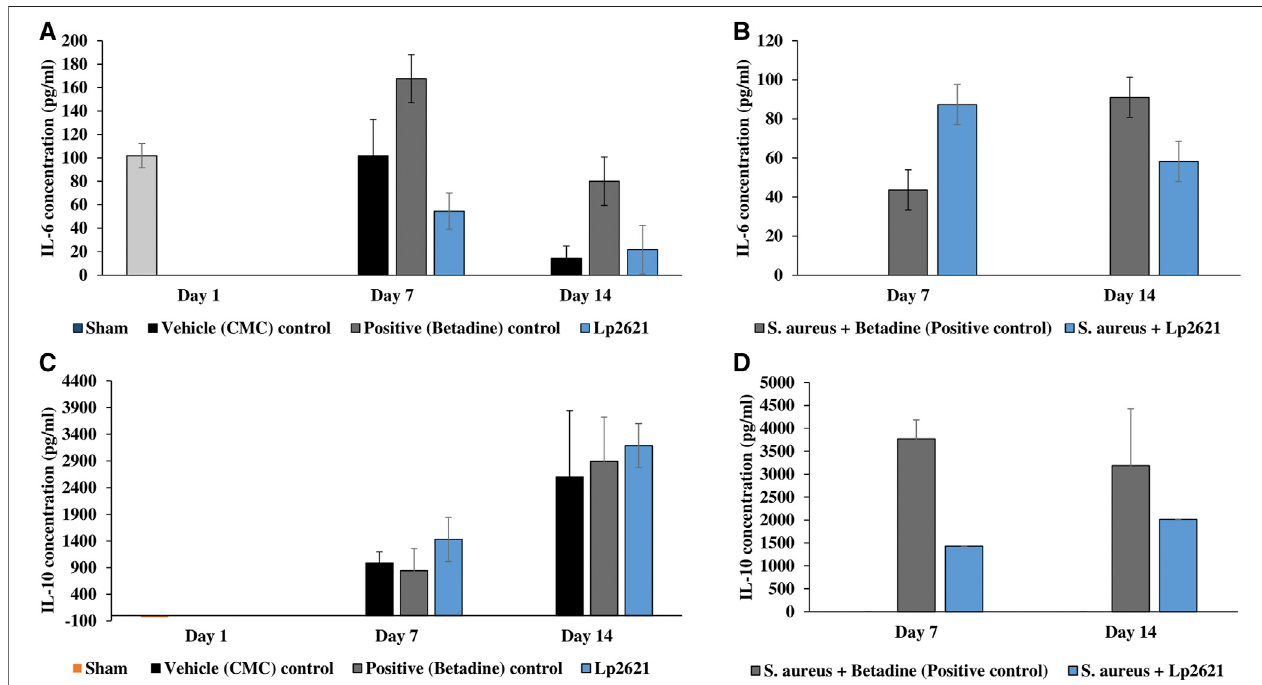
FIGURE 13 | Cytokine levels in the serum sample of mice. (A,B) IL-6 levels in the excision wound and the wound infected with S. aureus . (C,D) IL-10 levels in the excision wound and the wound infected with S. aureus . Data are representative of twoindependent experiments performed in duplicates and expressed asmean ± SE.